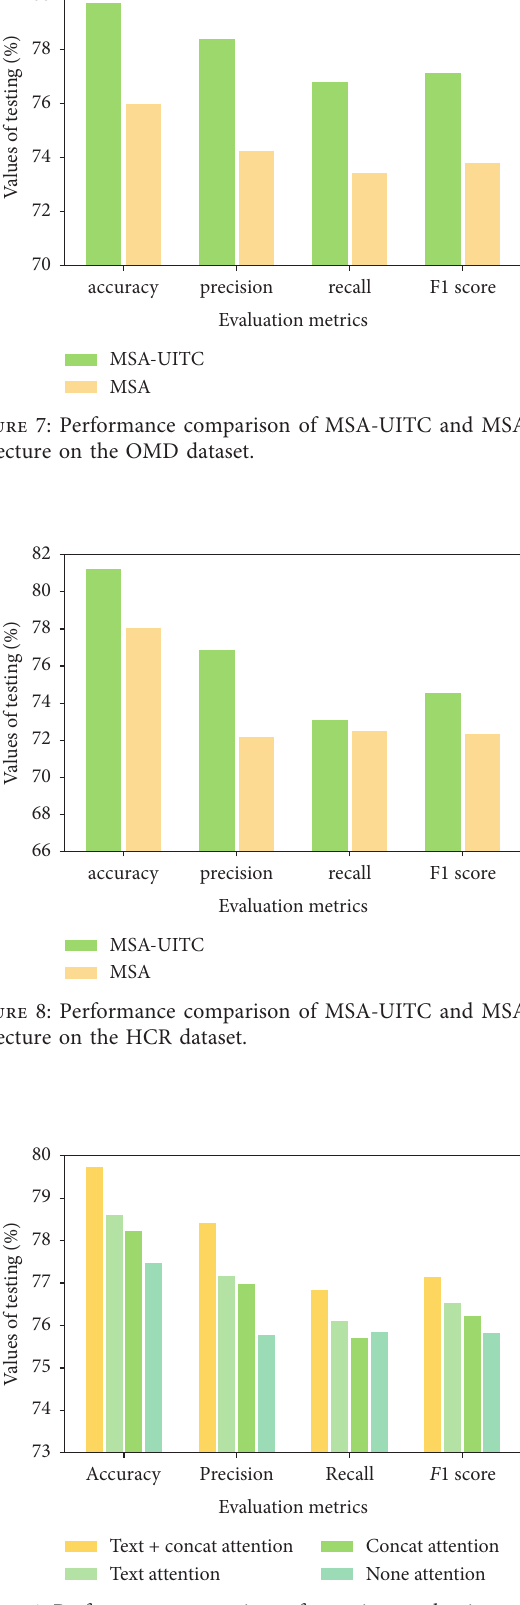
Figure 9: Performance comparison of attention mechanism on the OMD dataset.